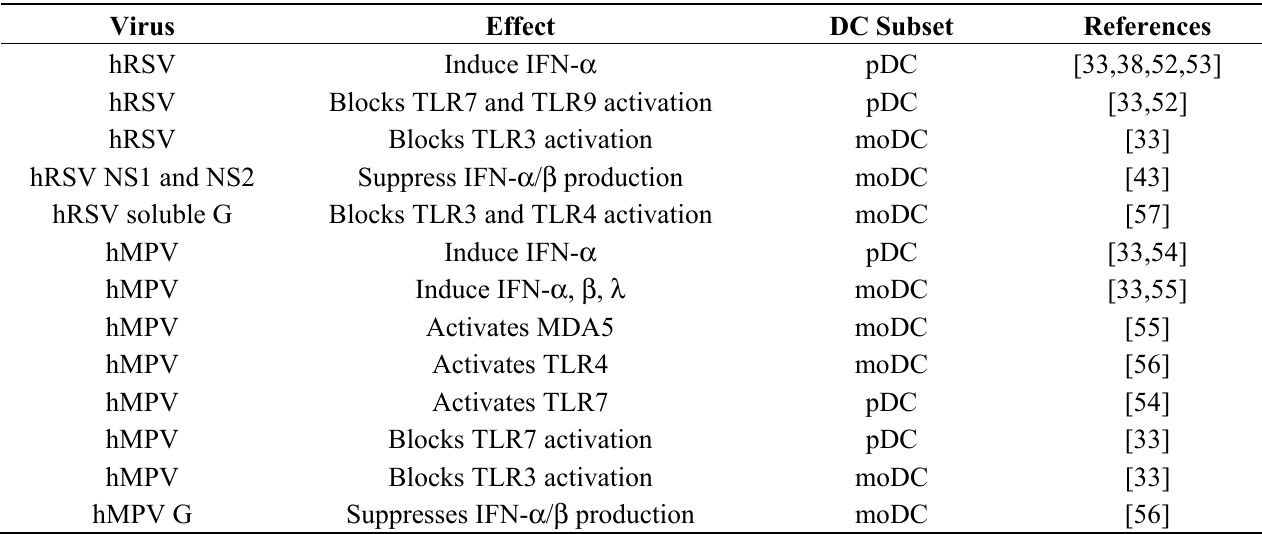
Table 1. Activation and inhibition of IFN responses by human respiratory syncytial virus (hRSV) and human metapneumovirus (hMPV) in dendritic cells (DC). pDC, plasmacytoid dendritic cells; moDC, monocyte-derived